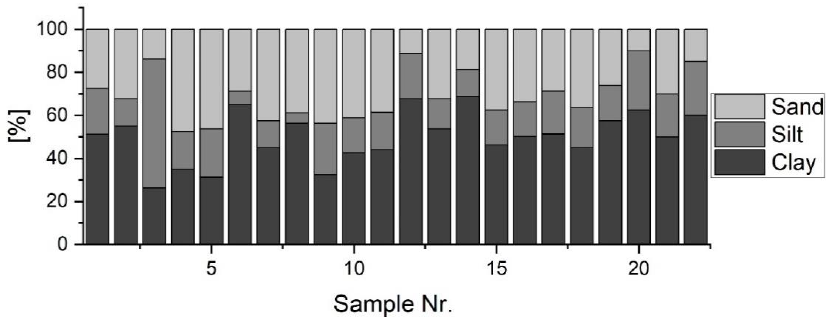
Figure 14. Texture of soil samples (sample number as in Figure 13a).